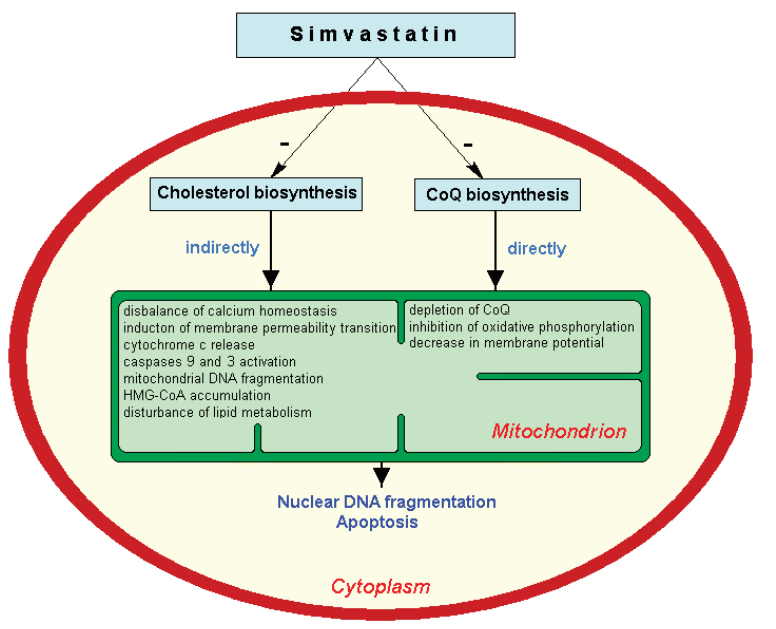
Figure 2. Summary of mitotoxic effects of